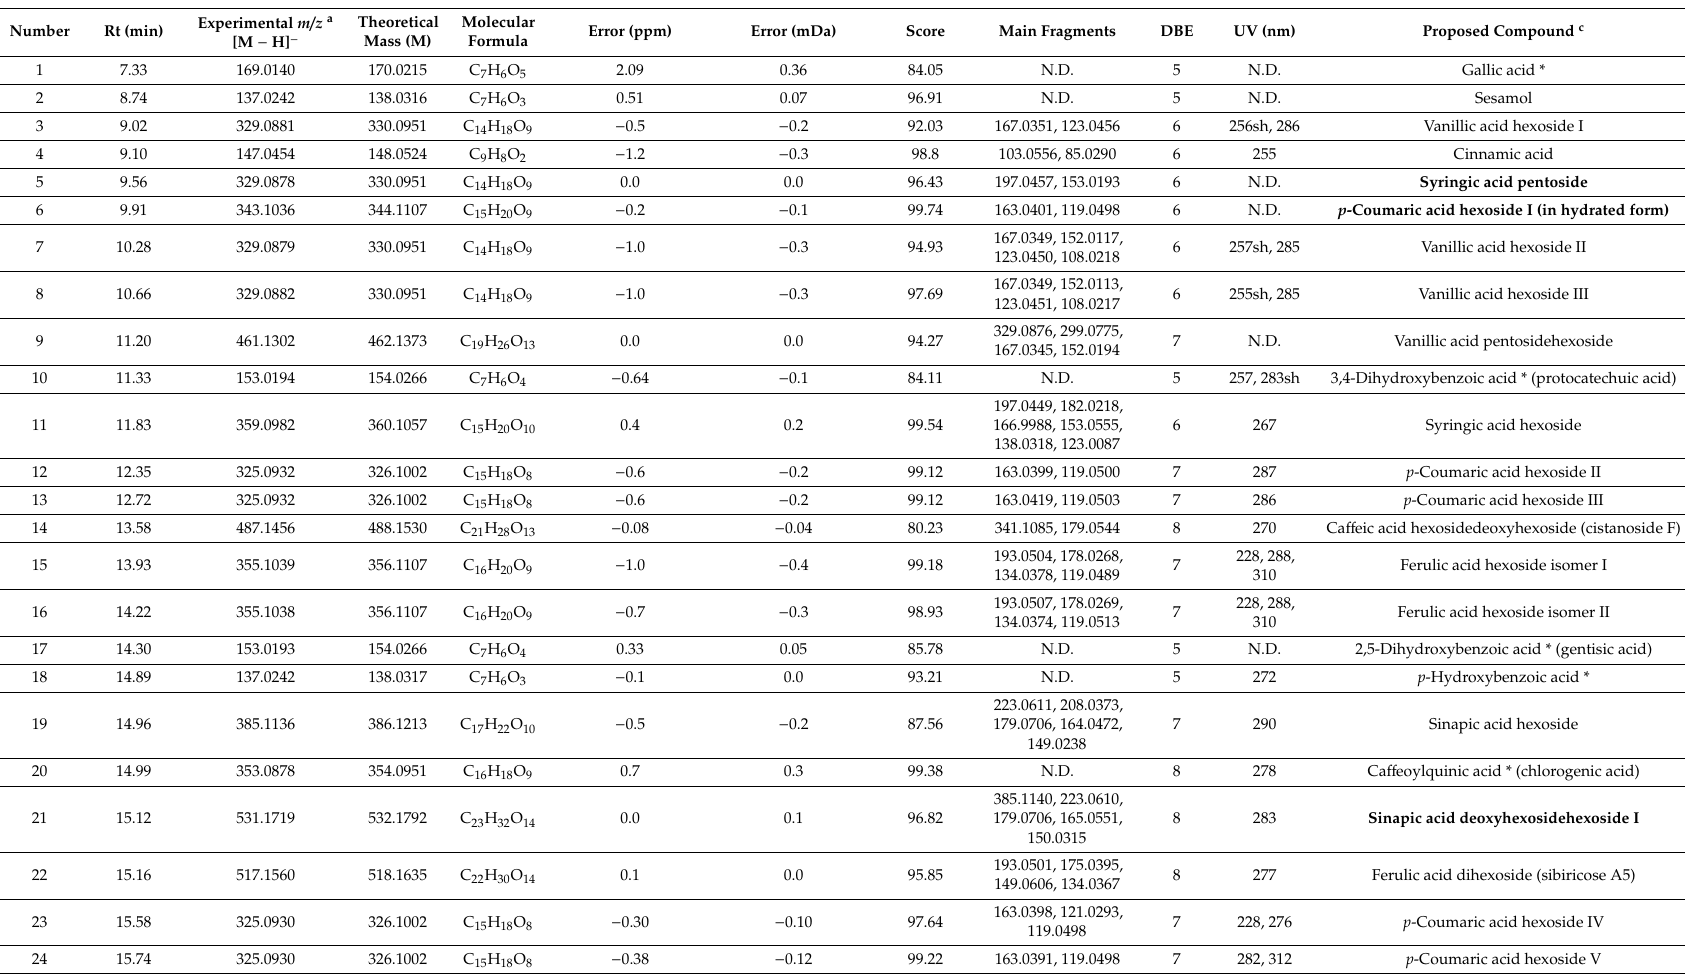
Table 1. Phenolic compounds characterized in the cake of the Egyptian cultivar of Sesamum indicum L. ‘Giza